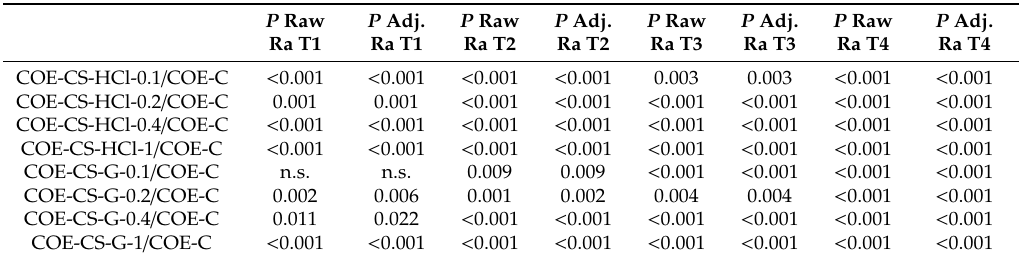
Table 5. Surface roughness p -values ( ≤ 0.05) raw and adjusted (adj.) by Bonferroni-Holm correction for Coe-Soft. P